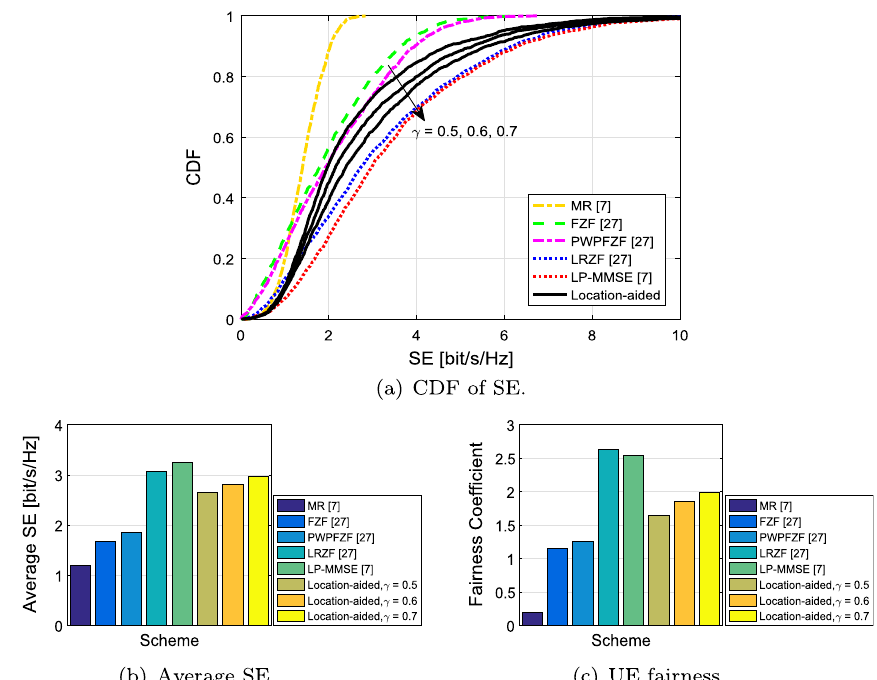
Fig. 3 The comparison of per-UE uplink SE, average SE and UE fairness of the proposed combining scheme with other combining schemes under different thresholds γ , where M 0.5, 0.6,